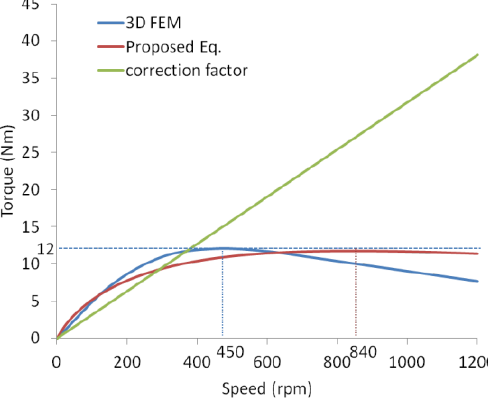
Figure 7. Braking torque in total.